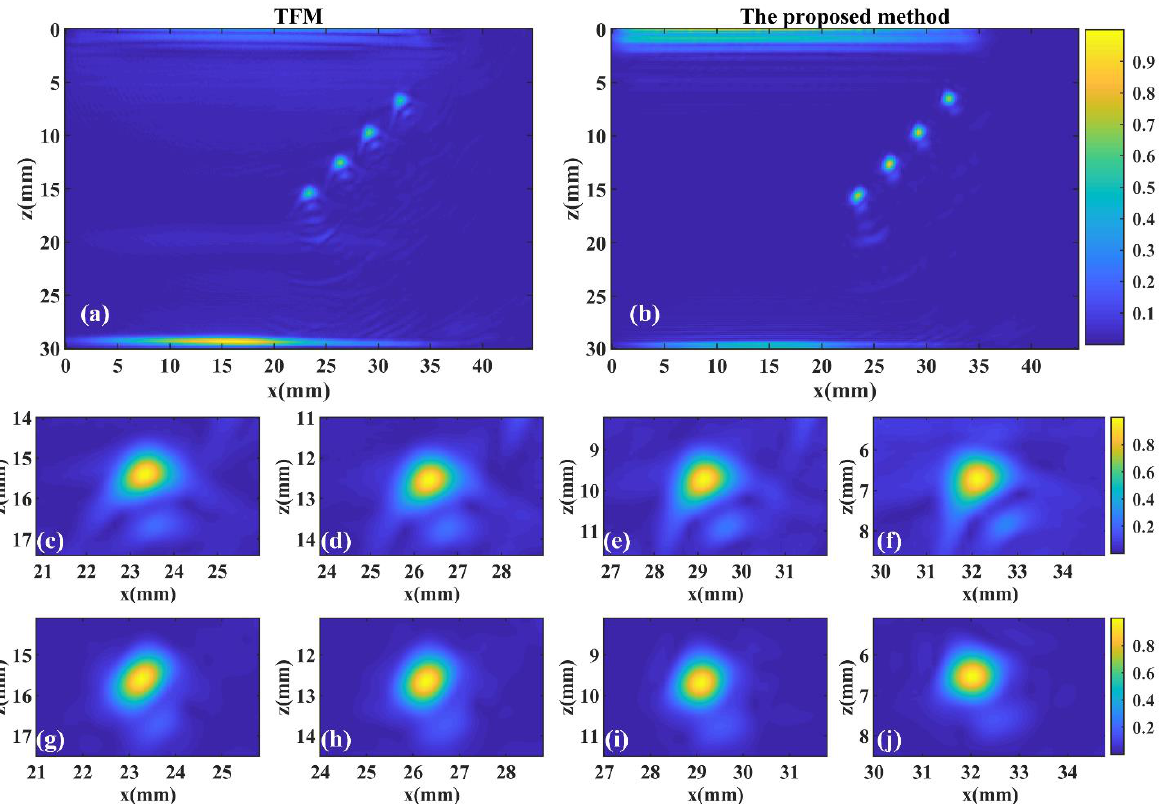
Figure 7. Experimental results reconstructed by TFM and proposed method. ( a ) The image reconstructed by TFM. ( b ) The image reconstructed by the proposed method. ( c – f ) The local enlarged images of the four SDHs in the result of TFM from left to right, respectively. ( g – j ) The local enlarged images of the four SDHs in the result of proposed method from left to right, respectively.